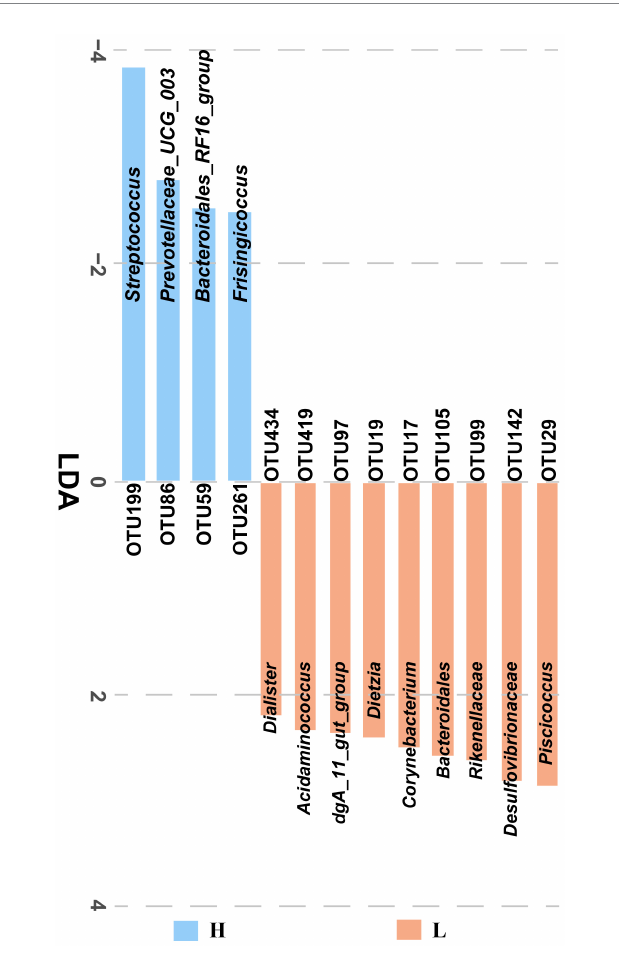
FIGURE 2 The identified significantly different OTUs in low and high finishing weight pigs. The “H” under the blue bar represents the high finishing weight group, and the “L” under the orange bar represents the low finishing weight